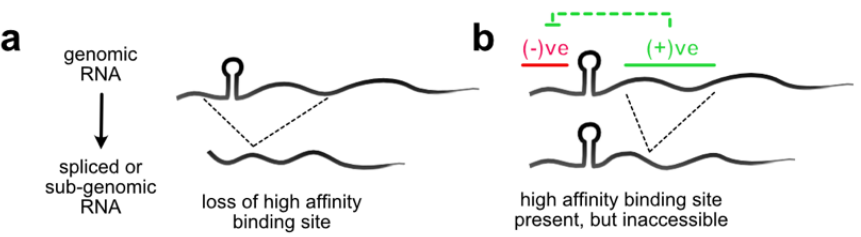
Figure 2. Selection of genomic RNA from non-genomic viral RNA. Dotted lines signify splicing or production of sub-genomic RNA. ( a ) Non-genomic RNA cannot be packaged because it does not contain the high affinity binding site for the (nucleo)capsid protein; ( b ) Non-genomic RNA contains the sequences for high affinity binding site, but it is not presented for binding. In HIV-1, negative regulatory elements ( − ve) upstream of the splice donor (SD) conceal the Gag binding site unless counteracted by positive regulatory (+ve) sequences downstream of the SD. Coronaviruses (CoV) have extraordinarily large genomes (~30 kb) that presumably pose additional difficulties for packaging, yet genomic RNA is efficiently and selectively incorporated into virions [5,59–61]. Accumulating evidence suggests that SARS-CoV-2 exploits liquid-liquid phase separation (LLPS) during its replication [62–70] (Figure 3). LLPS occurs when biological molecules condense into a phase resembling a liquid droplet, and is an emerging paradigm for organizing membrane-less viral factories [71,72]. It is a common property of RBPs containing intrinsically disordered regions (IDR), such as the SARS-CoV-2 nucleocapsid (N) [64,67,68,73]. LLPS of N protein is enhanced in the presence of viral RNA [62,65], and even though N protein binds throughout the genomic RNA [62,70], LLPS is specifically promoted by RNA sequences at the 5 (cid:48) and 3 (cid:48) of the SARS-CoV-2 genome (Figure 3) [62]. Interestingly, other sequences, such as the CoV frameshift site, were found to disperse condensates [62], and importantly, sub-genomic RNA was efficiently excluded from preformed droplets [62]. This demonstrates that for LLPS mediated packaging, the biophysical properties of RNA-protein interaction are as important as the protein-RNA affinities. LLPS likely promotes viral assembly by enhancing interaction between RNA and N protein within a privileged site [62], but may have other roles in viral replication, such as hiding viral RNA from cellular immune sensors [74,75]. Packaging sites may also include motifs necessary for the correct presentation of the RNA molecule in time and space. For example, influenza viruses have a segmented genome of negative sense viral RNAs (vRNAs) that are replicated in the nucleus via complementary RNA (cRNA) intermediates. Long-range interactions between the 5 (cid:48) and 3 (cid:48) termini, in some cases over distances of thousands of nucleotides, construct the promoter structure that is involved in transcription, replication and packaging [76]. Interestingly, cRNAs and vRNAs are both complexed into ribonucleoproteins (vRNPs) with very similar protein compositions, but only vRNPs are packaged into virions. Slight differences in promoter structures between vRNPs and cRNPs, due to imperfect complementarity between the terminal sequences, affect its interaction with the viral M1 protein that acts as a bridge between vRNPs and the nuclear export machinery. This structural difference allows the virus to discriminate between cRNPs and vRNPs by either preventing nuclear export of the cRNP [77] or by changing nuclear export pathways [78] (Figure 3). In the same vein, several studies show that the binding of the HIV-1 Rev protein to its cognate RNA structure, the Rev Response Element (RRE), enhances genome packaging [79–81]. Surprisingly, this enhancement effect seems to be unrelated to the role of Rev/RRE in increasing cytoplasmic RNA levels. Rather, the Rev/RRE is proposed to enhance packaging by defining the correct nuclear export pathway and subcellular localization of the genomic RNA [79–82] (Figure